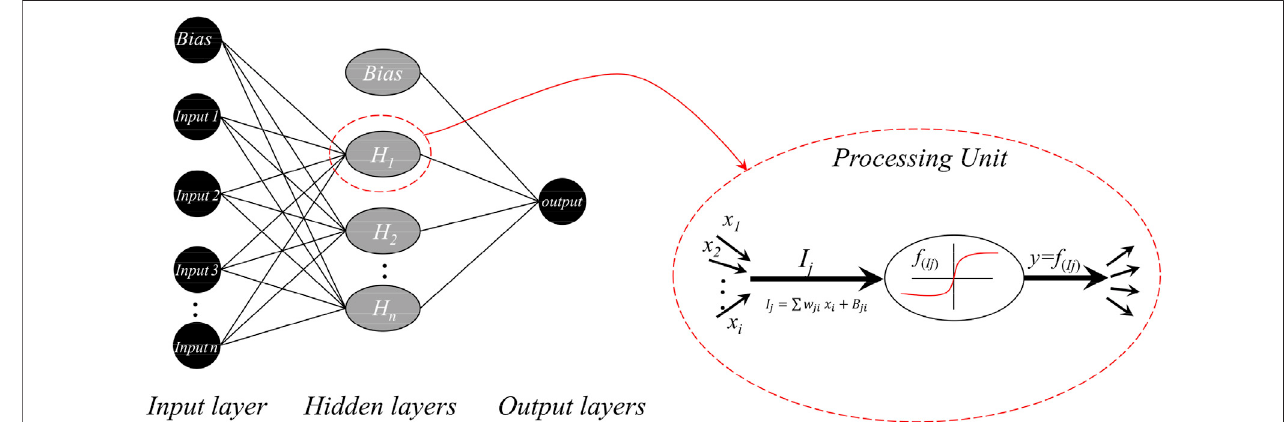
FIGURE 3 | General structure and processing unit of ANNs.